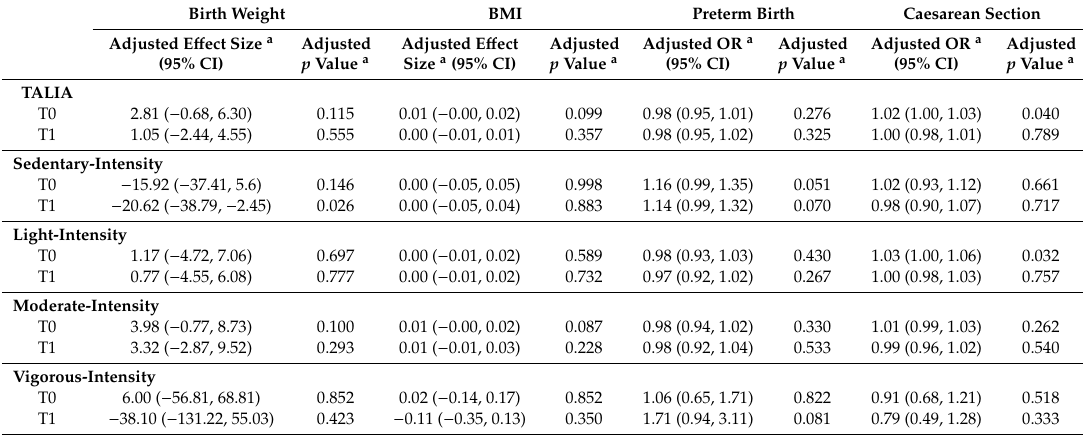
Table 3. Associations between physical activity intensity and infant anthropometrics and obstetric outcomes. Birth Weight BMI Preterm Birth Caesarean